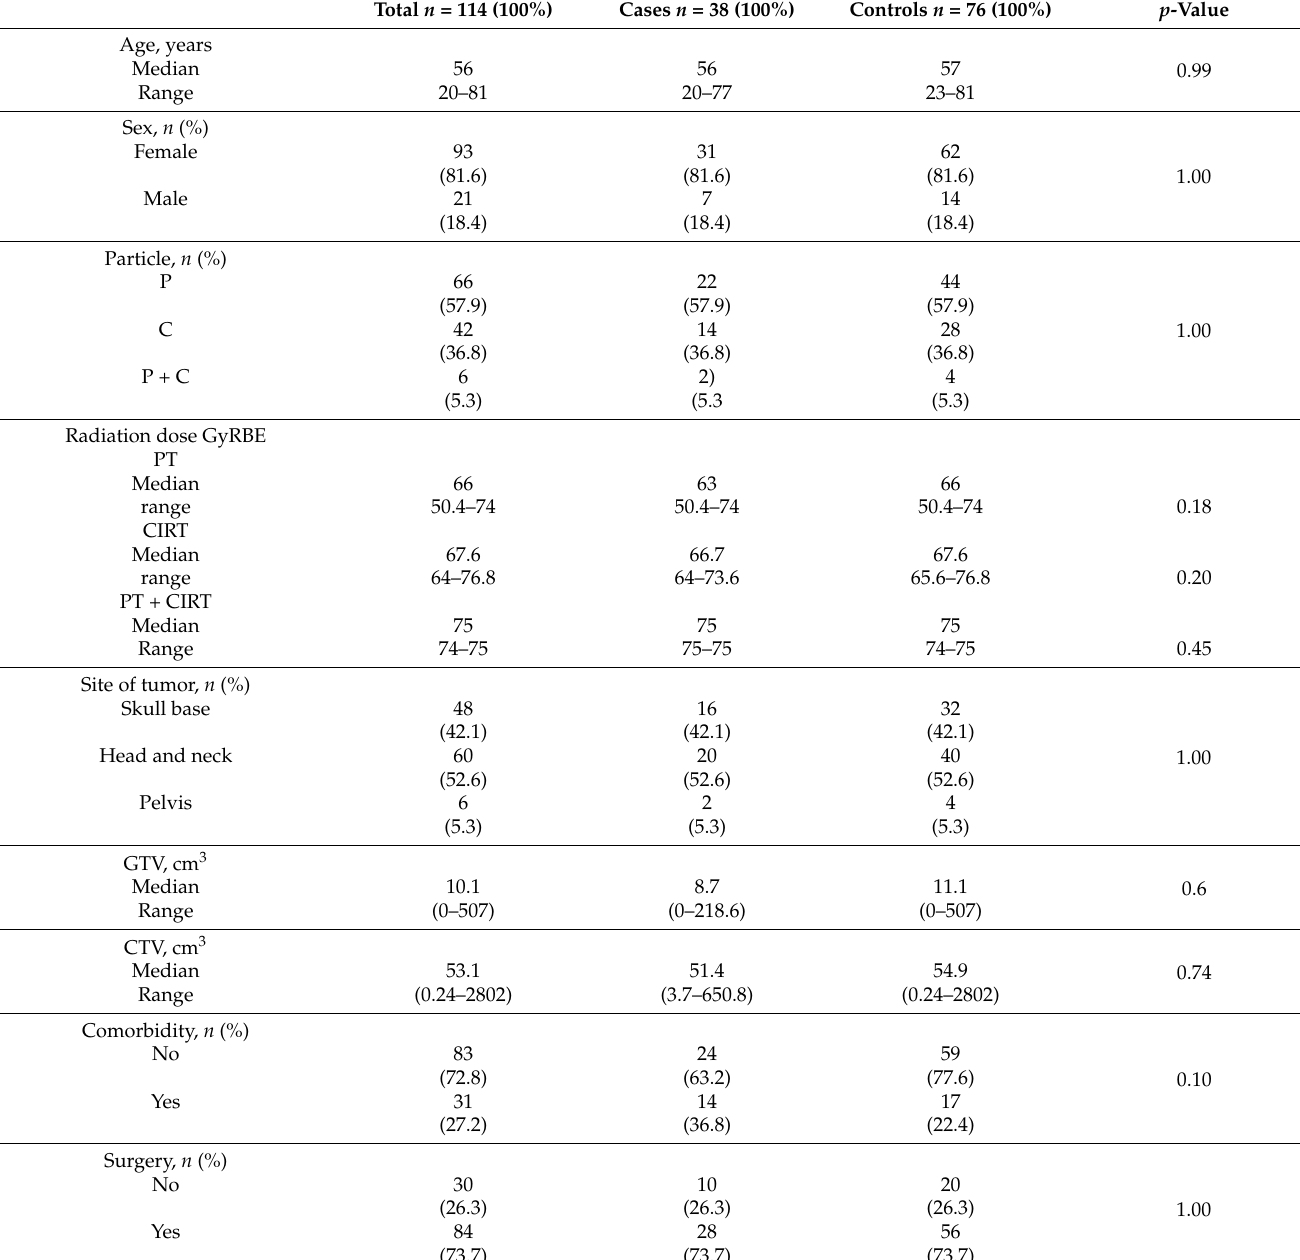
Table 1. Patient